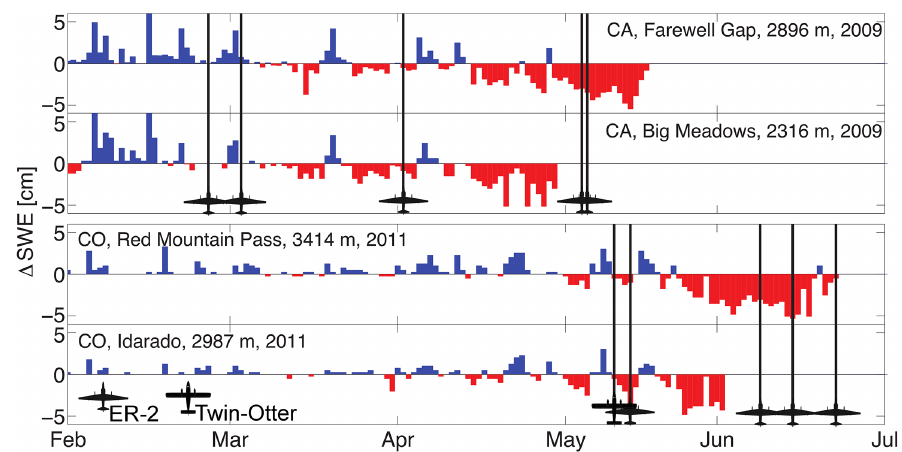
Figure 3. Snow accumulation (blue) and snowmelt (red) indicated with the differential snow water equivalent ( (cid:49) SWE) with respect to time. The AVIRIS flight dates are marked with black vertical lines and a symbol indicating the ER-2 or Twin Otter airborne platform. The upper plot shows snow sensor pillow data from two stations representing a higher and a lower location in the Sierra Nevada, CA, study area in 2009. The lower plot shows the same information, but from stations close to the Rocky Mountains, CO, study area in